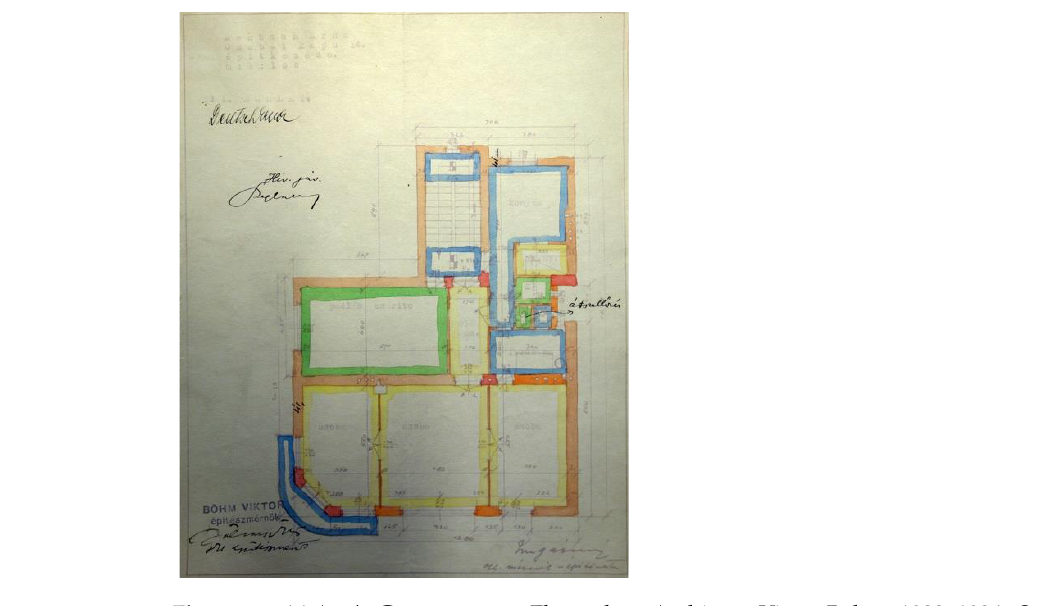
Figure 14. 16 Art ú r Görgey street. Floor plan. Architect: Victor Bohm, 1932–1934. Source: MNL Figure 14. 16 Artúr Görgey street. Floor plan. Architect: Victor Bohm, 1932 – 1934. Source: MNL Arts 2022 , 11 , x FOR PEER REVIEW BAZML IV. 1906/b. 1435/1934. BAZML IV. 1906/b. 1435/1934.